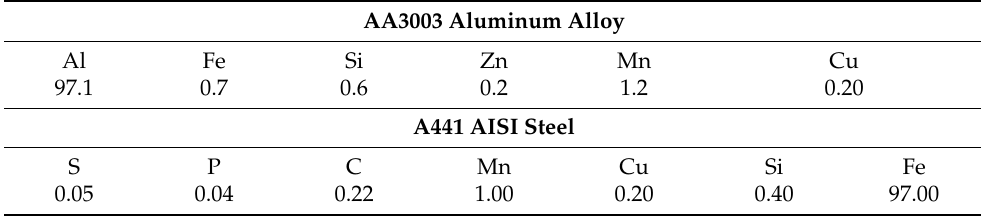
Table 2. Chemical composition of base